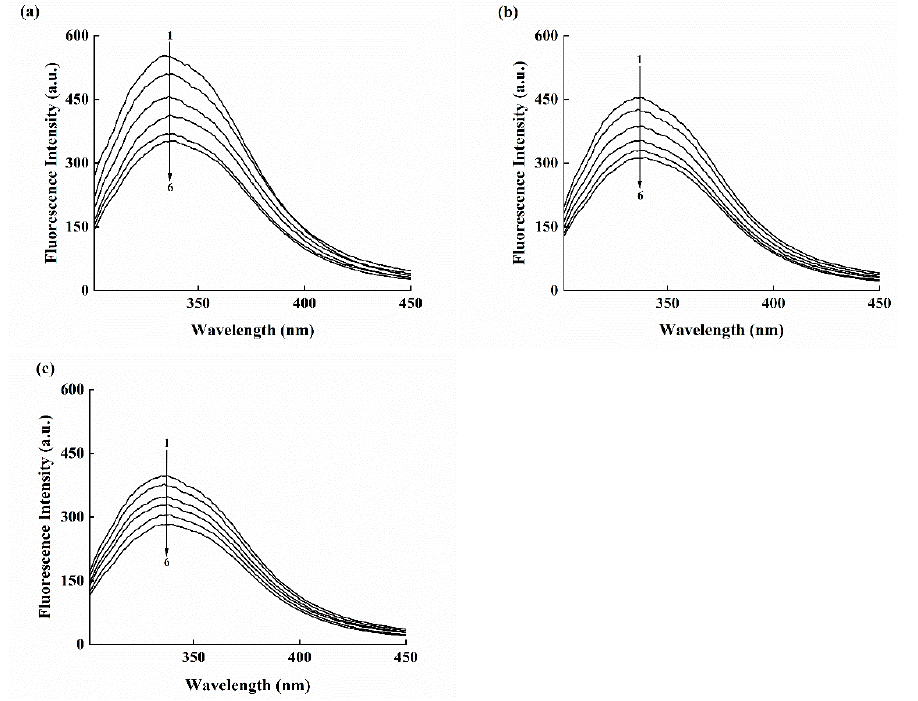
Figure 5. Spectra of the SPA (62.5 μ M) fluorescence quenching upon binding to Mal-mPEG5000. c(Mal-mPEG5000) = 0.0, 62.5, 125.0, 187.5, 250.0 and 312.5 μ M for curves 1–6, at different tempera- ture ( a ) 298 K ( b ) 308 K ( c ) 318 K. ( a ) 298 K ( b ) 308 K ( c ) 318